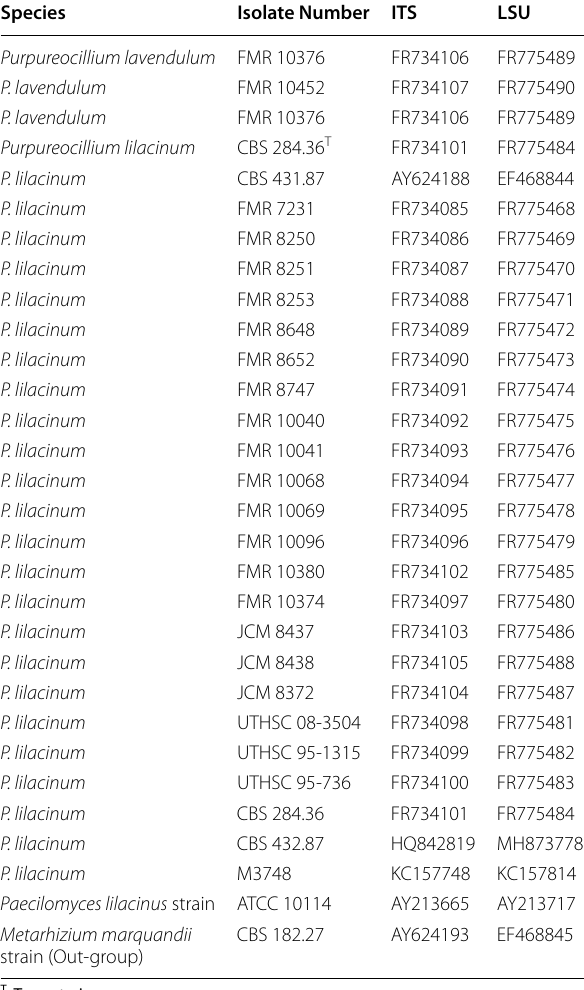
Table 1 Species, isolates and accession number included in the